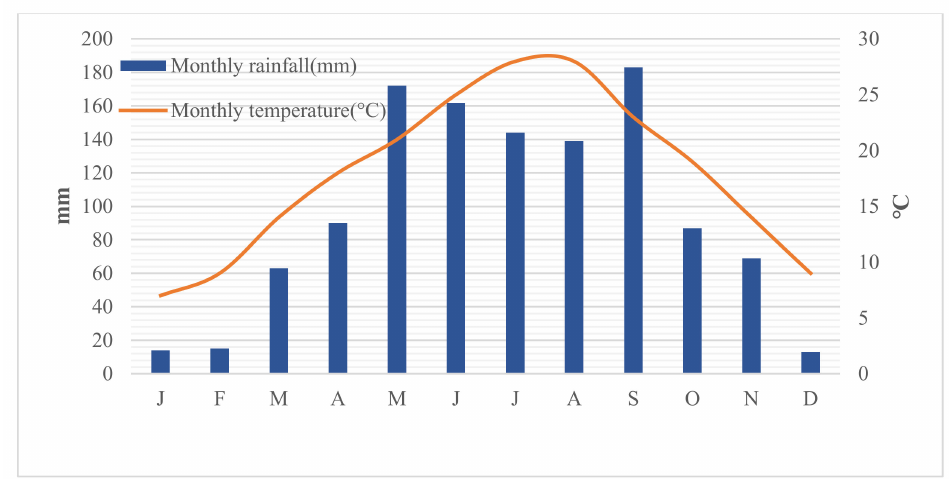
Figure 2. Rainfall and temperature distribution in Yunyang County